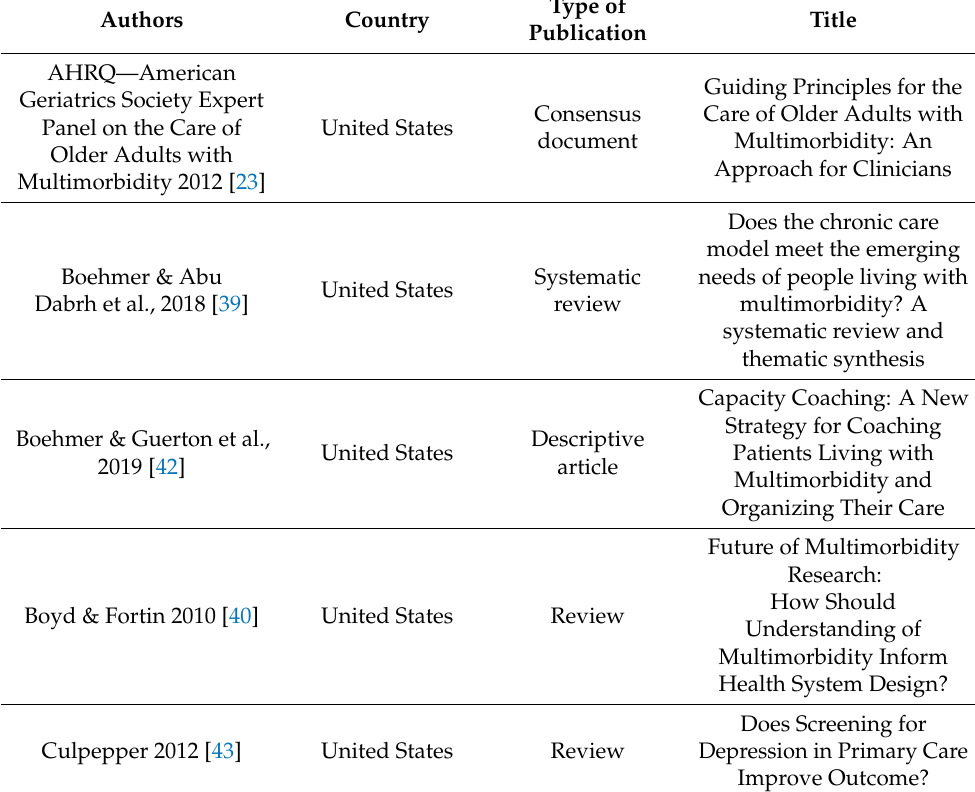
Table 3. Details of the publications included in the scoping review; publications are listed in alpha- betical order of the